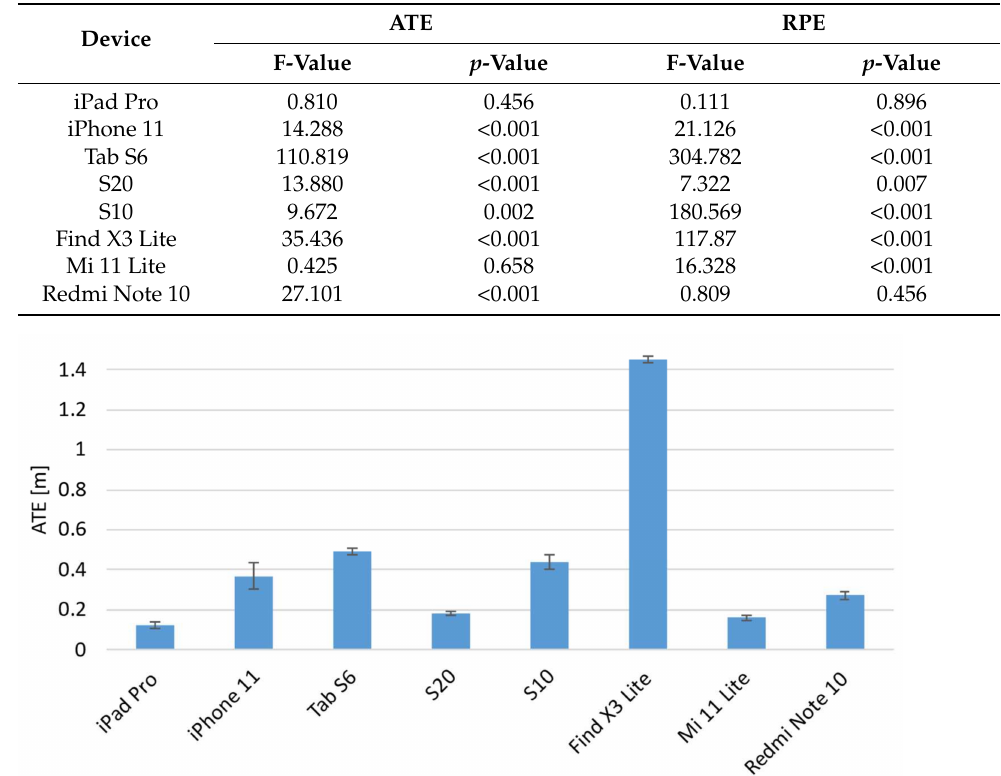
Figure 9. Averaged RPE for the selected devices over the three paths (eight-, square-, and U-shaped trajectories). Table 3. Analysis of variances for ATE and RPE metrics over all paths for each device.